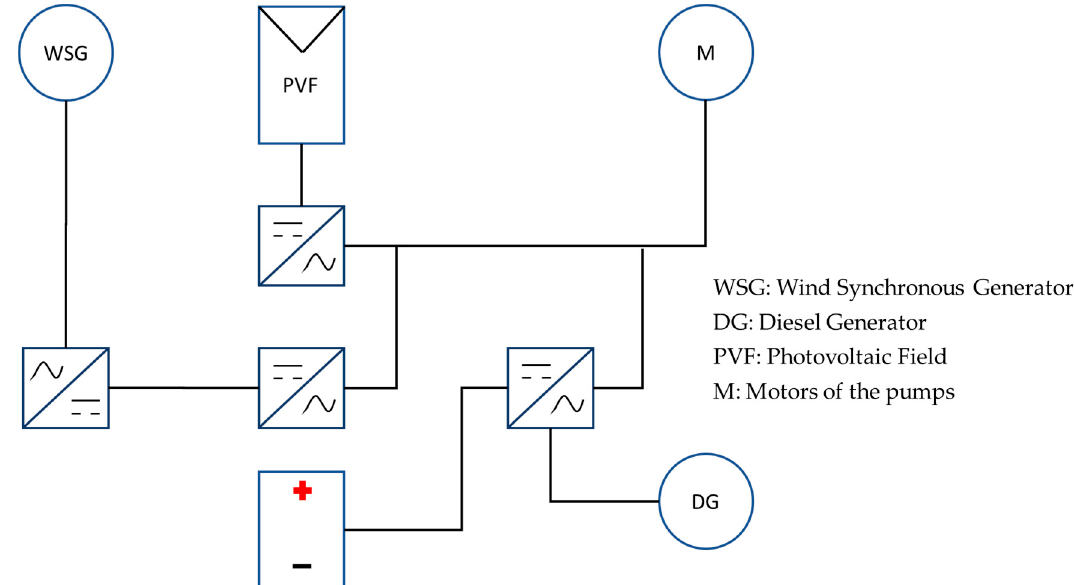
Figure 5. Basic scheme with a multigeneration system. Source: [53].